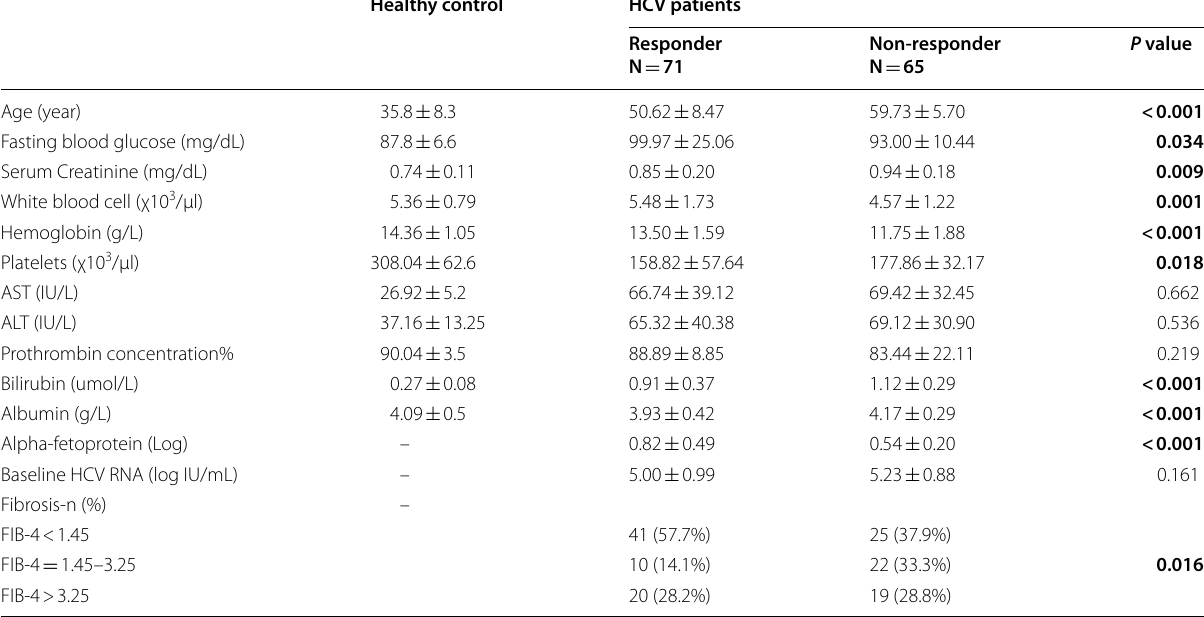
Table 1 The relation between clinical characteristics and treatment outcome in hepatitis C patients treated with SOF healthy